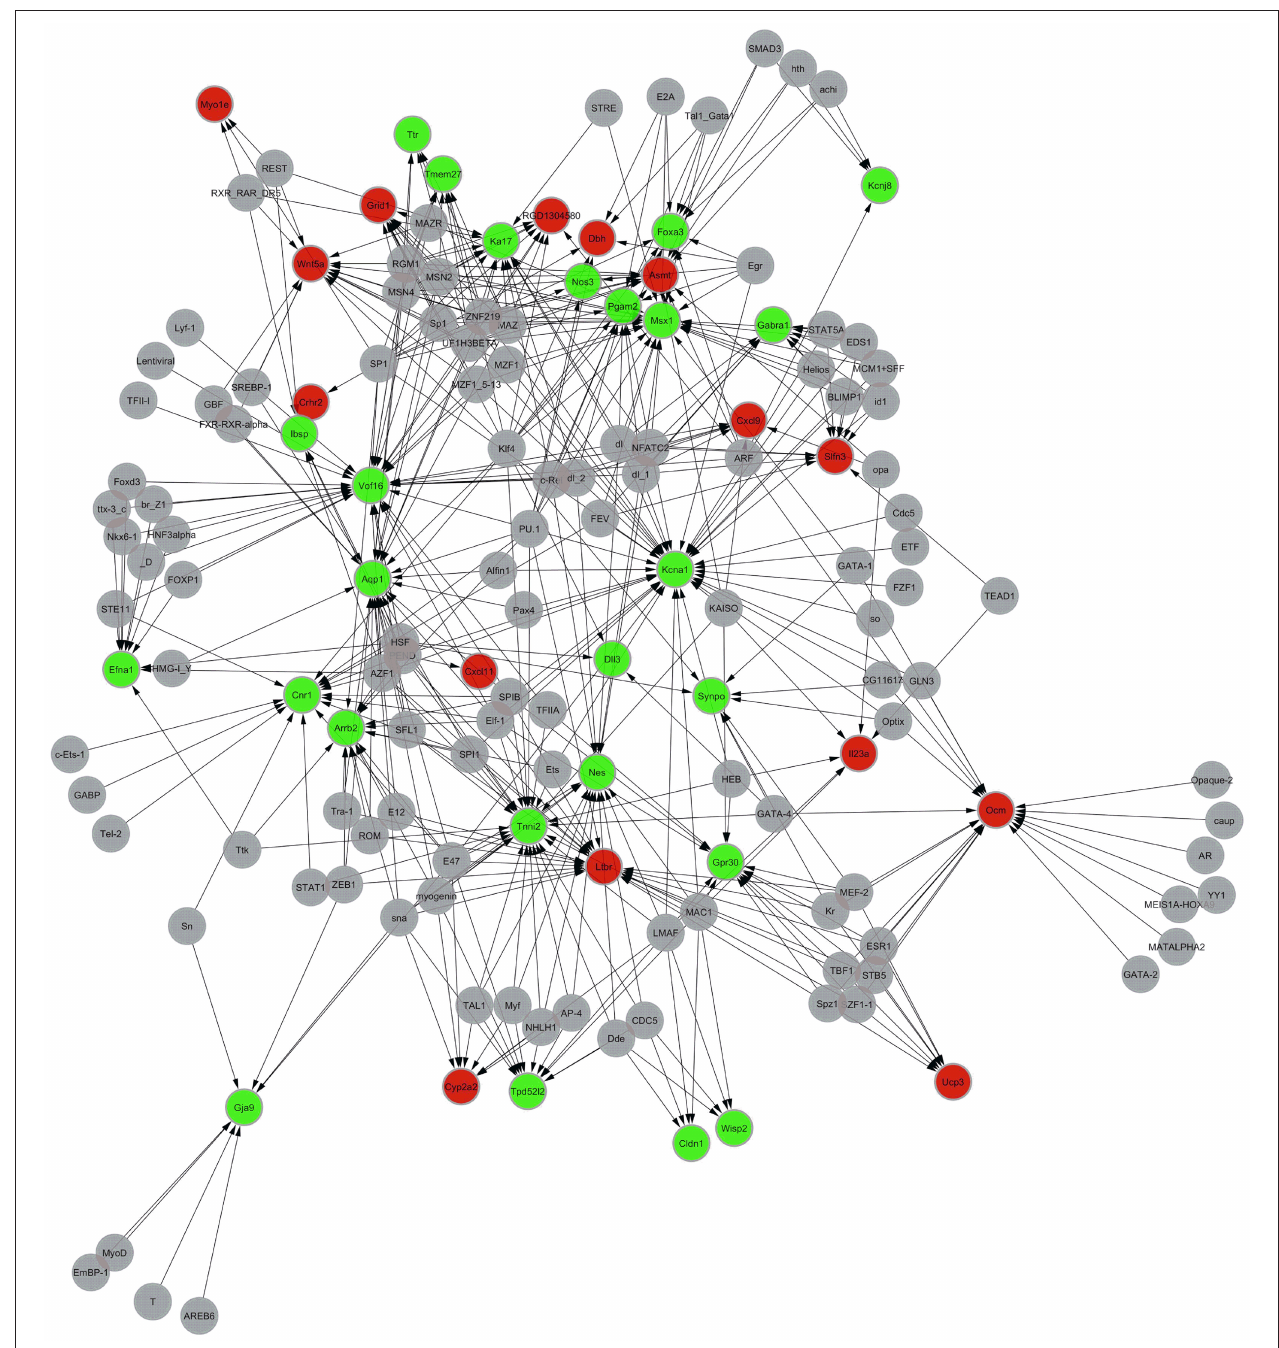
FIGURE 2 | Diagram of the networks regulating the transcription of the differentially expressed genes in the model group compared with the XYS group. Red and green represent upregulated and downregulated genes, respectively, and gray represents TFs. The arrow indicates the direction in which the TF target (TFT) genes are regulated by transcription factors